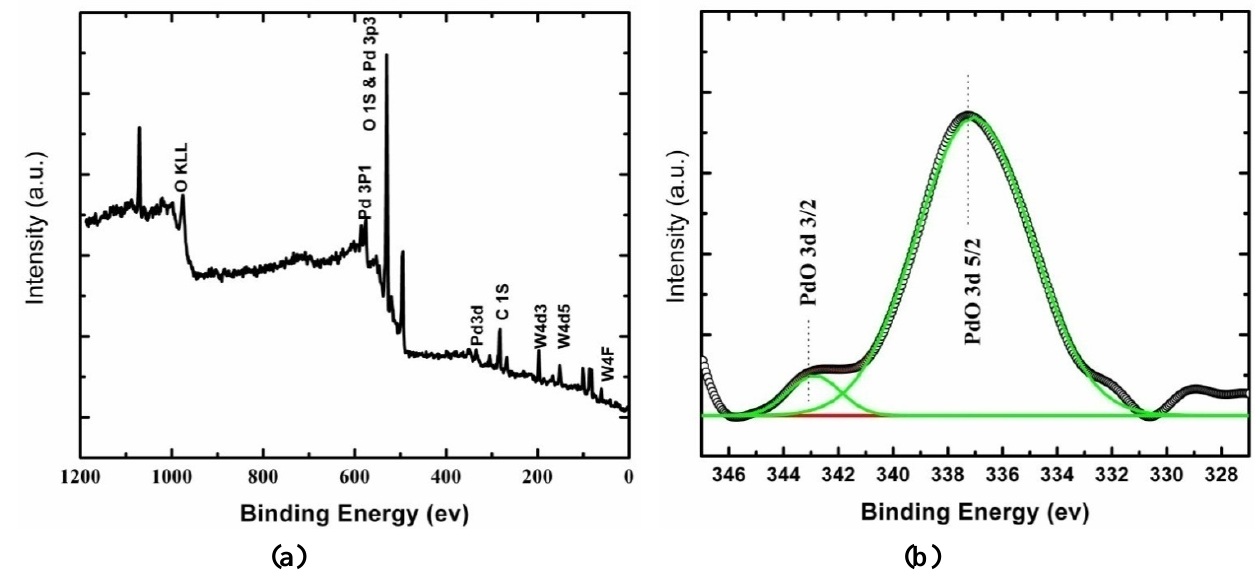
Figure 3. The X-ray photoelectron spectroscopy (XPS) patterns of the Pd doped WO nanofiber that was heat treated at 500 °C, ( a ) Peak survey and ( b ) Deconvolution in the Pd 3d